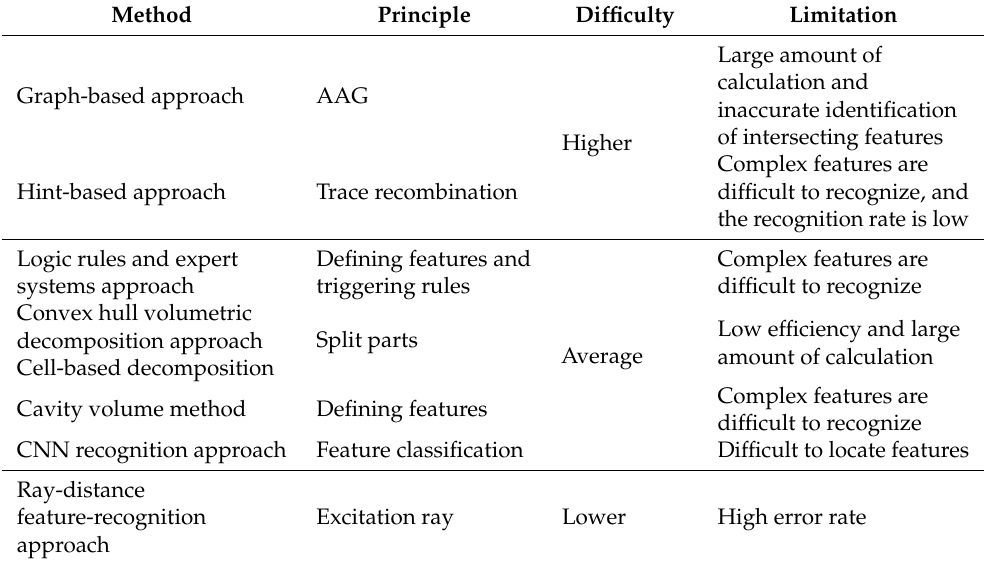
Table 2. Comparison of part feature recognition